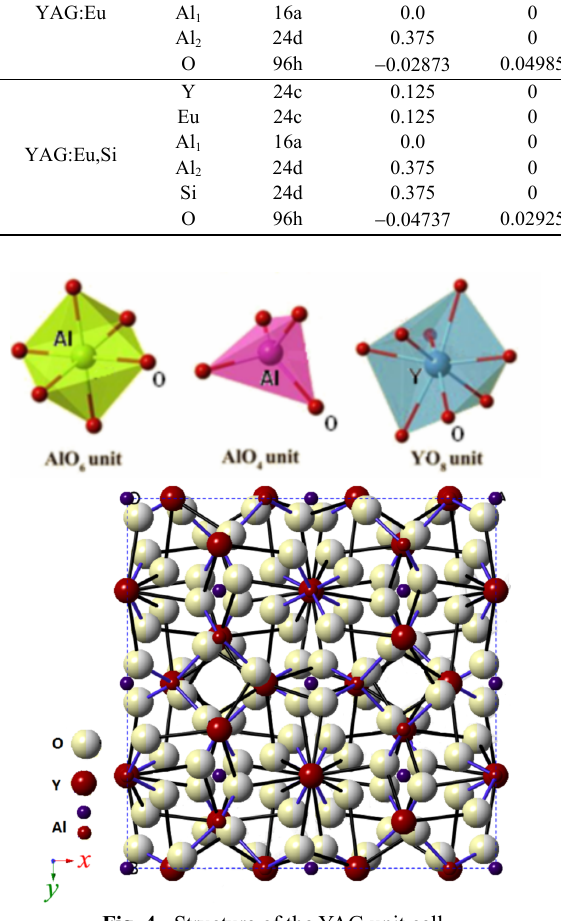
Fig. 4 Structure of the YAG unit